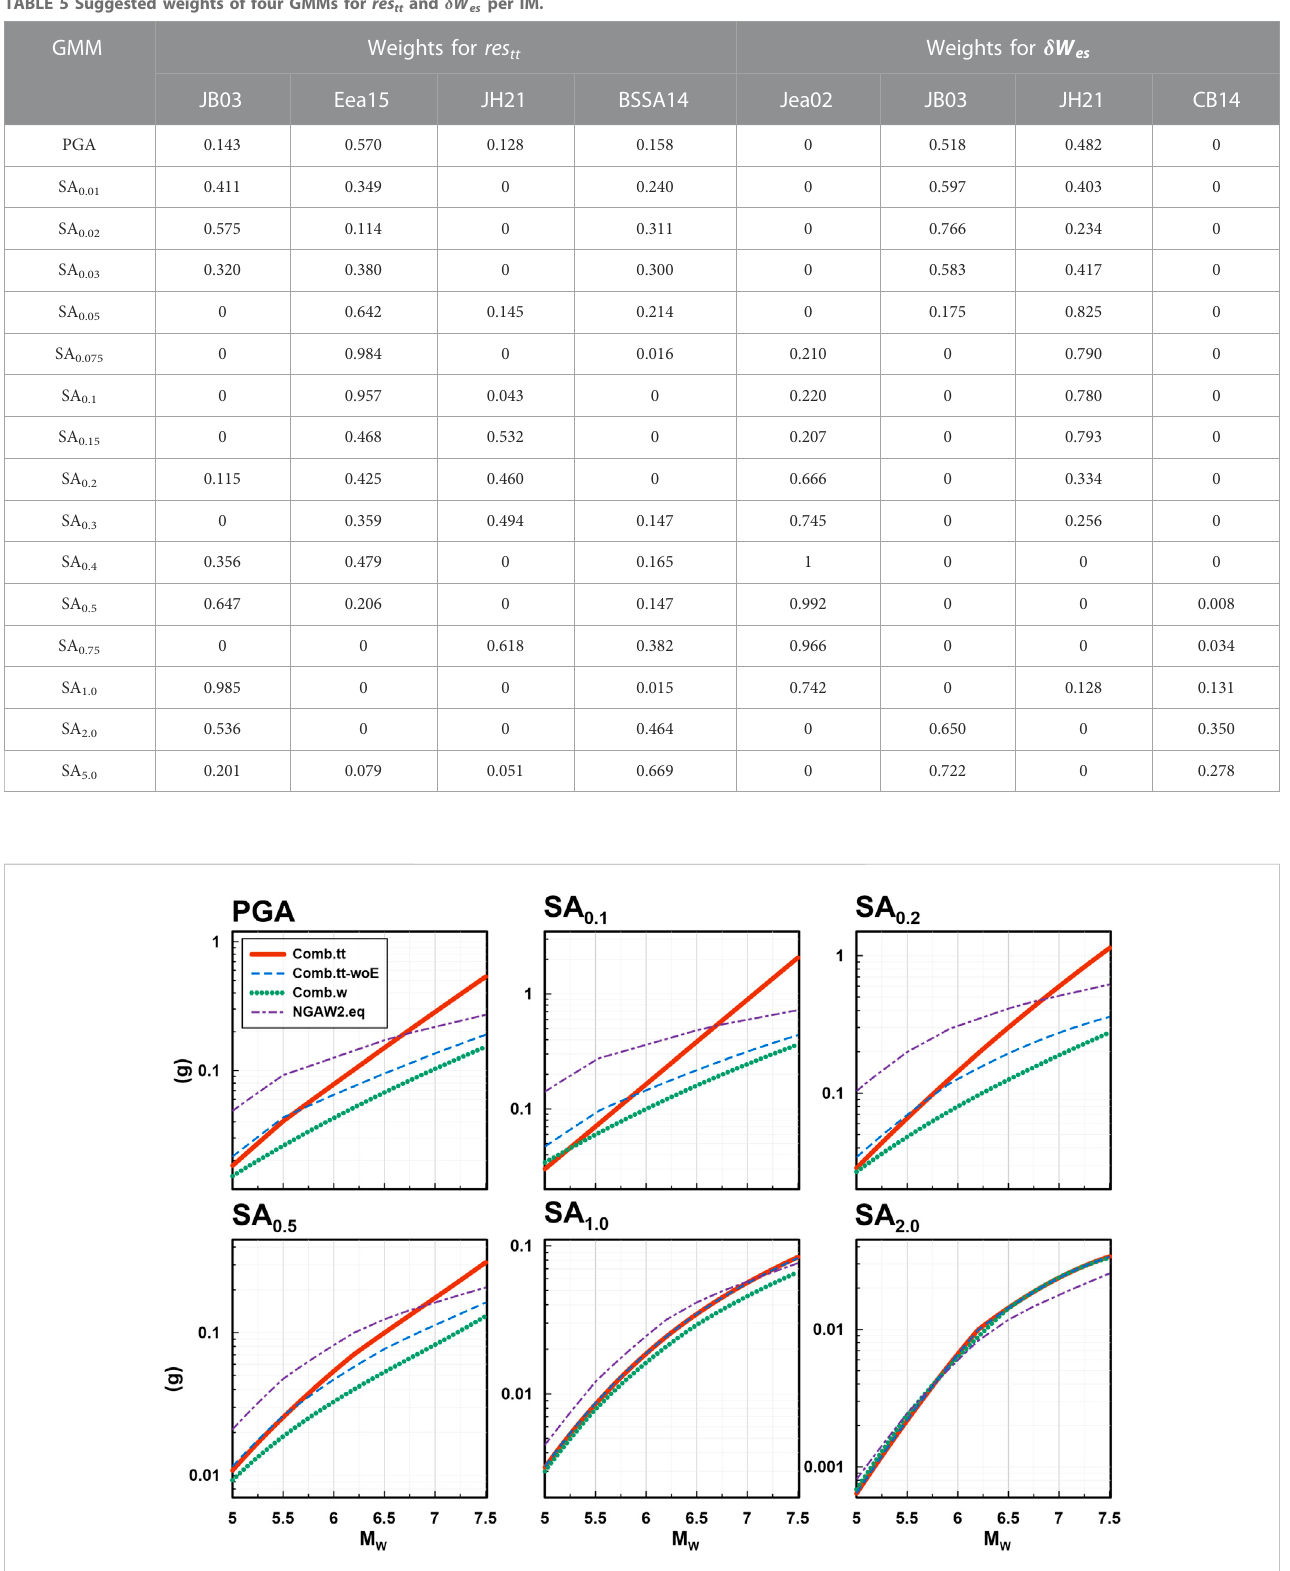
FIGURE 8 Comparison of magnitude scaling of PGA, SA 0.1 , SA 0.2 , SA 0.5 , SA 1.0 , and SA 2.0 for combined GMMs (Comb tt , Comb tt-woE , and Comb w ) with equally weighted NGA W2 models